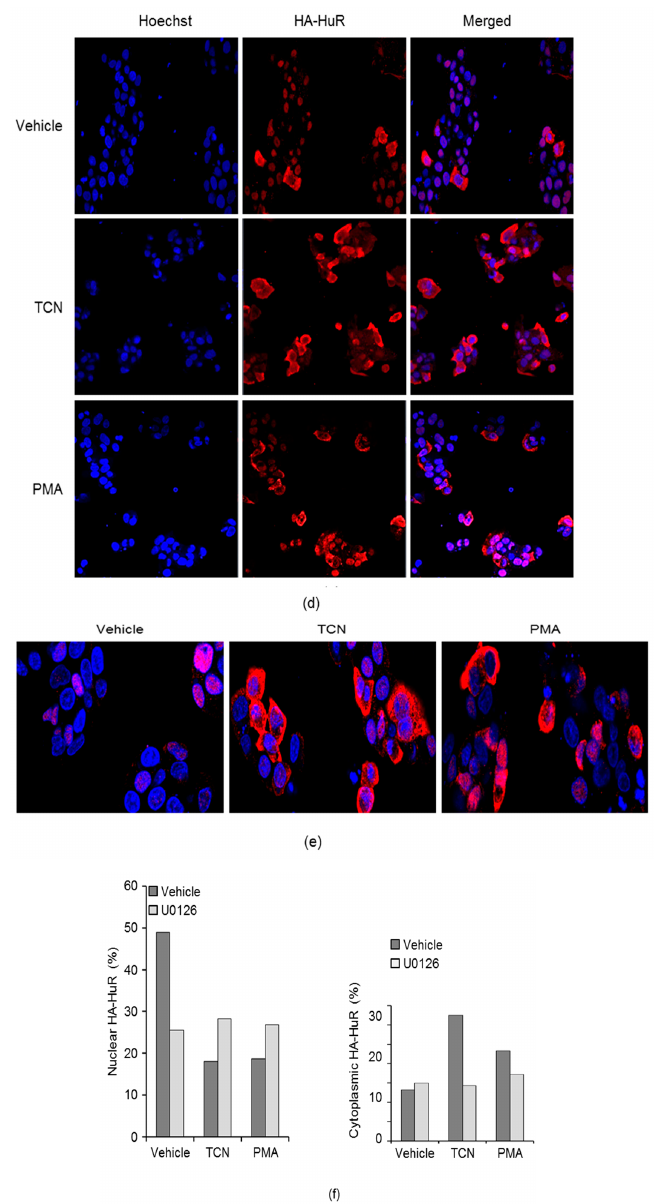
Figure 6. TCN induces translocation of nuclear HuR to cytoplasm in an ERK-dependent manner. ( a ) HepG2 cells were treated with, or without U0126 for one hour prior to addition of TCN or not for four hours and total lysate were immunoblotted with the indicated antibodies. ( b ) the cells were treated with TCN for four hours and subjected to subcellular fractionation with NE-PER ™ Nuclear and Cytoplasmic Extraction Reagents. Nuclear and cytoplasmic fractions were immunoblotted with the indicated antibodies. ( c ) Cells were treated with, or without, U0126 for one hour prior to the addition of TCN for four hours and subjected to subcellular fractionation and the cytosolic fraction was immunoblotted with the indicated antibodies. ( d ) HA-HuR transfected cells were exposed to TCN or PMA for four hours and further examined by confocal immunofluorescence microscopy with anti-HA. ( e ) Merged picture of HA-HuR and nuclei (Hoechst) in cells treated as described in ( d ) and with an increased resolution compared to ( d ). Red: HA-HuR, Alexa fluor 647, blue: nuclei, Hoechst. One representative experiment is shown ( n = 3). ( f ) Nuclear and cytoplasmic HA-HuR was localized in 600–900 cells for each treatment. the proportion of cells with nuclear and cytoplasmic HA-HuR, respectively, to the total number of cells counted, are shown ( n =